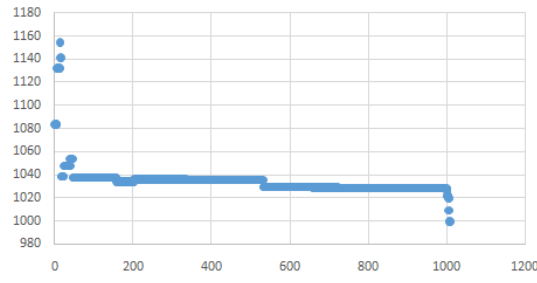
Fig. 7: Convergence Curve for 5 Unit System for a Fixed Hour Table 7: Comparison of Ten-Unit Test System